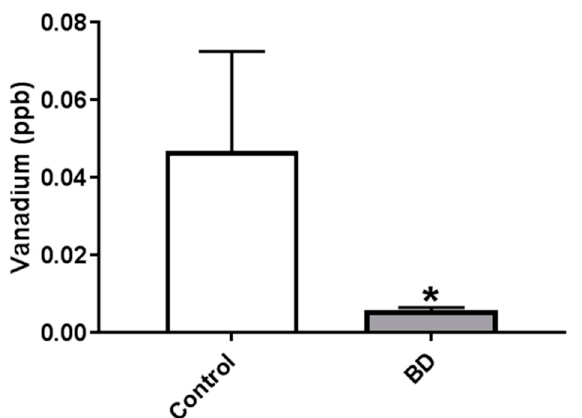
Figure 2. Vanadium concentrations in PFC of BD patients and matched controls. PFC brain samples were obtained from the human postmortem brain tissue collection at the Human Brain Collection Core, National Institute of Mental Health (NIMH). Vanadium concentrations were determined as described in Materials and Methods. Results are expressed as mean ± SEM, n = 20. The difference between the groups was analyzed utilizing nonparametric Exact One ‐ tail Mann–Whitney Test. * significantly lower than control samples, p < 0.05.